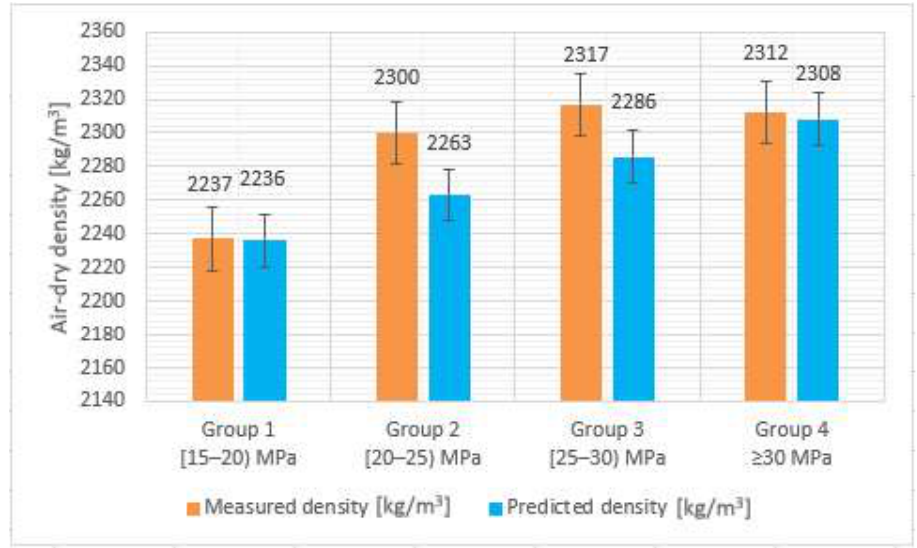
Figure 4. Air-dry density, mean values.